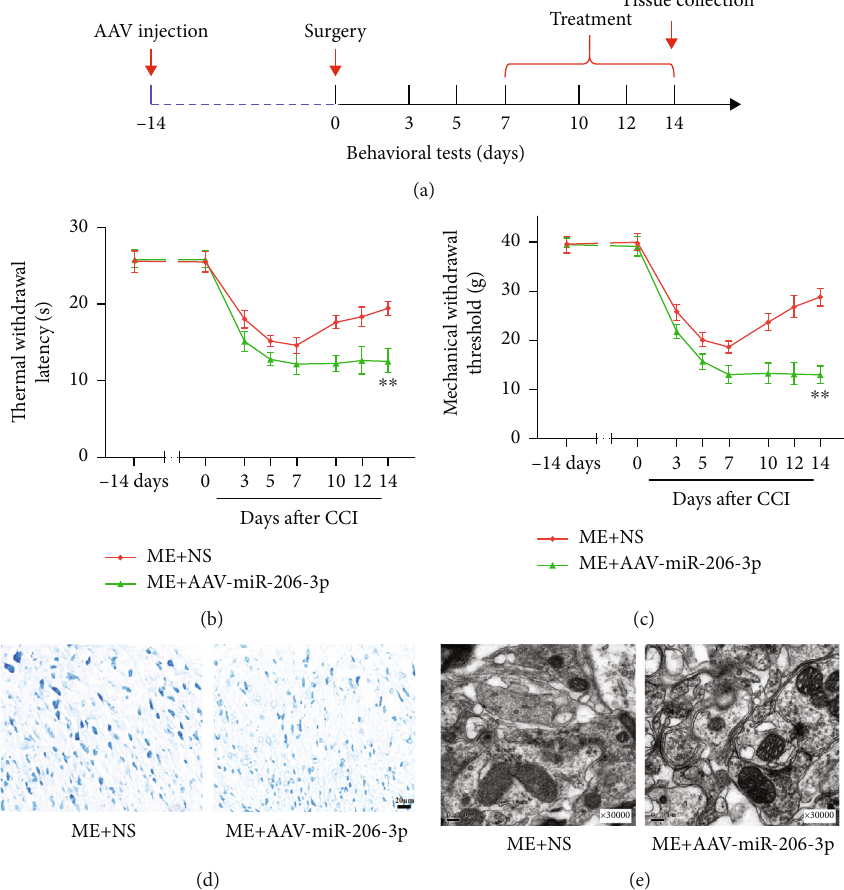
Figure 5: A miR-206-3p inhibitor blocked the therapeutic e ff ect of EA and did not alleviate hyperalgesia. (a) Experimental design and timeline. (b, c) MWT and TWL in each group ( n = 14 ). (d) Nissl staining images (scale bars: 20 μ m, 50x). (e) The ultrastructural changes of synapses in each group (0.2 μ m, 30000x). ∗∗ p < 0 : 01 versus ME+NS